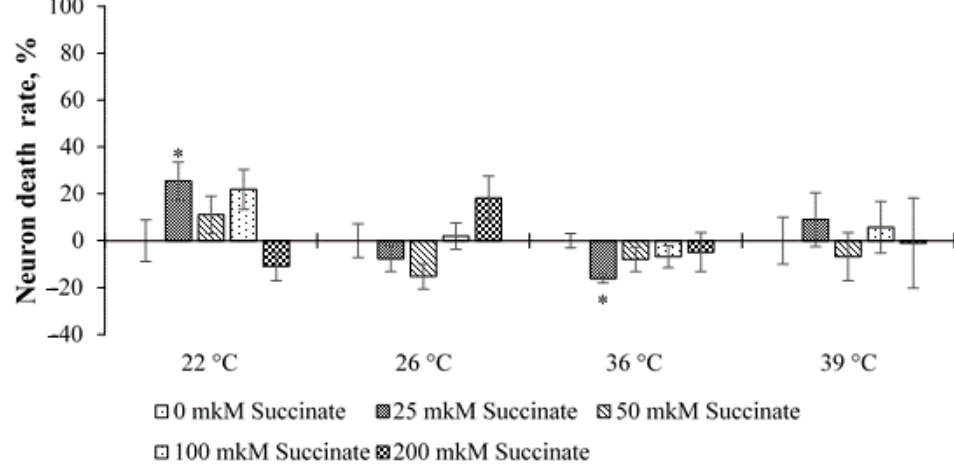
Figure 4. The death rate of cerebellum neurons, depending on the temperature and concentration of succinate for ISS—150 ppm. Comparison refers to the points of the 150 ppm—0 μM succinate (100%). Data are represented by M ± m. * p < 0.05 in relation to the point of 150 ppm. Note: 1—ISS is 150 ppm, 0 μM succinate; 2—ISS is 150 ppm, 25 μM succinate; 3—ISS is 150 ppm, 50 μM succinate; 4—ISS is 150 ppm, 100 μM succinate; 5—ISS is 150 ppm, 200 μM succinate. A significantly different picture was observed in cultures with 50 ppm